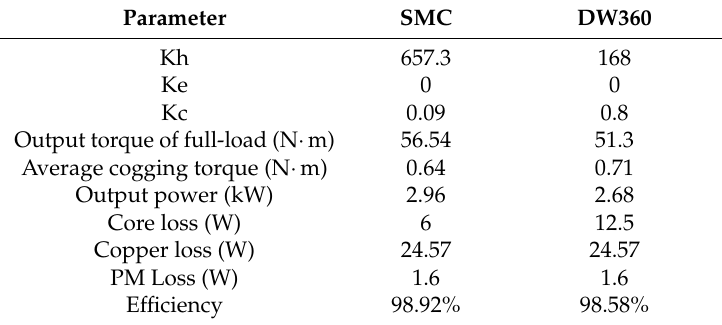
Table 2. Performance results with different